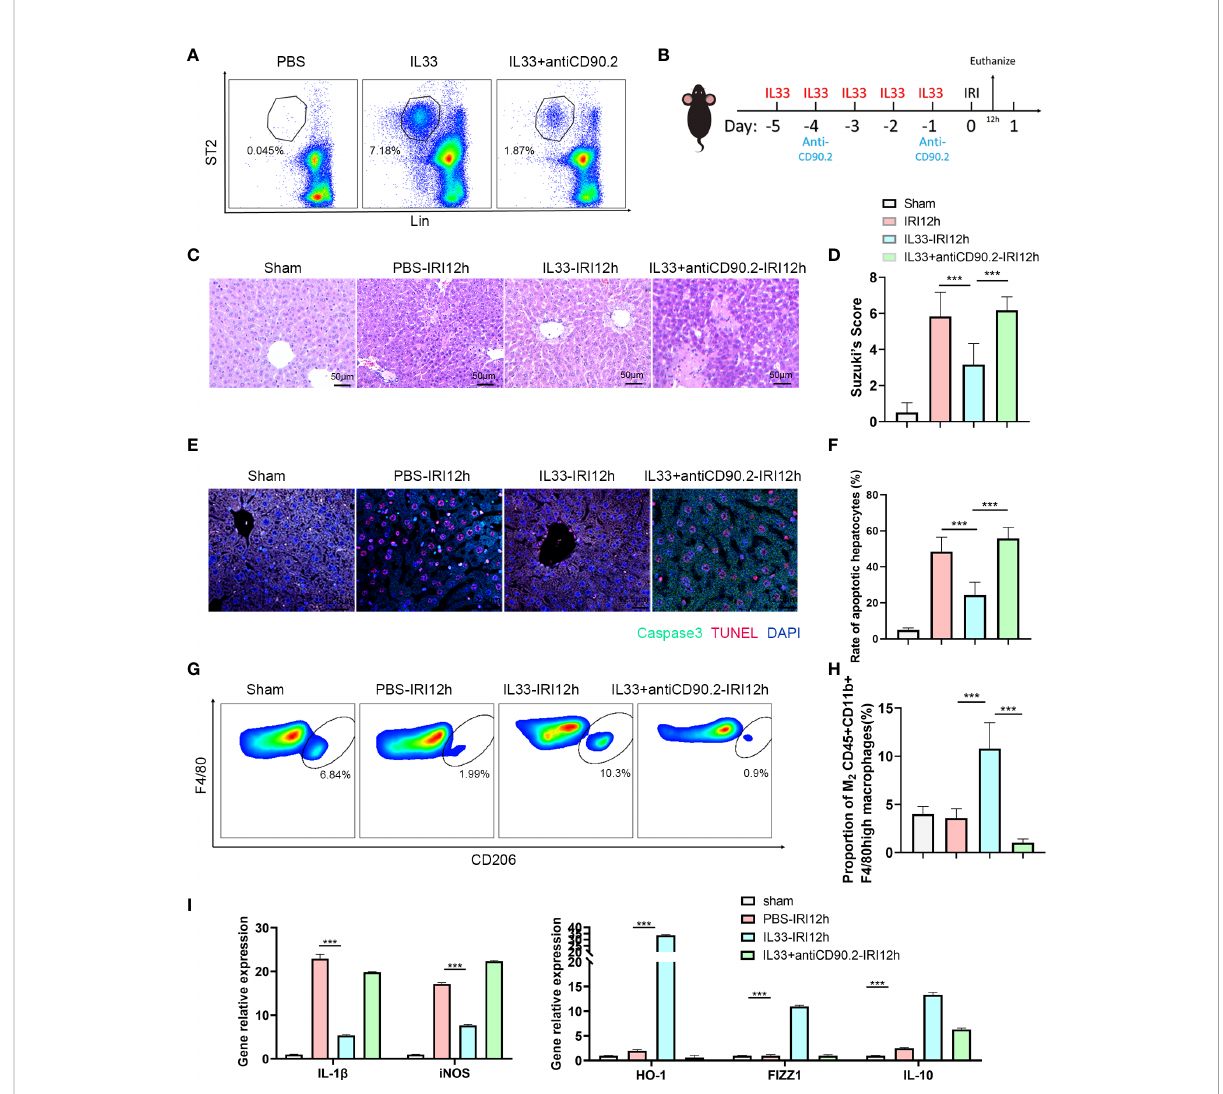
FIGURE 3 ILC2s protect liver from IRI by increasing the proportion of M2 CD45+CD11b+F4/80high macrophages (A) Representative FACS analysis showing that exogenous IL-33 administration signi fi cantly increased the proportion of ILC2s in liver as compared with PBS controls and IL-33 receiving anti-CD90.2 administration, which signi fi cantly depleted ILC2s. (B) Sketch map of medicine administration and IRI surgery. Mice were treated with exogenous IL-33 daily for 5 consecutive days as well as anti-CD90.2 antibody twice before IRI surgery. Mice were euthanized 12 h after reperfusion. (C) HE staining of Sham, PBS, IL-33 and IL33&anti-CD90.2 groups as determined at 12 h after reperfusion (×200). (D) Suzuki ’ s Scores resulting from IR-induced liver injury in Sham, PBS, IL-33 and IL33&anti-CD90.2 groups (n=6 per group). (E) Representative cell apoptosis immuno fl uorescence of the 4 groups as determined at 12 h post-reperfusion. Cell apoptosis was measured using TUNEL (red) and Caspase3 (green). Apoptotic cells display a red nucleus (TUNEL) and green cytoplasm (Caspase-3) while normal cells show blue nuclei (DAPI) (×400). (F) Histograms of quantitative analysis of TUNEL-positive cells (n = 6 per group). (G) Representative FACS analysis showing the proportion change of M2 CD45+CD11b+F4/80high macrophages. (An CD206+ increase in proportion was assumed as a M2 polarization among CD45+CD11b+ F4/80high cells) (H) Quantitative analysis of percent of M2 CD45+CD11b+F4/80high macrophages (n = 5 per group). (I) Relative gene expressions of IL-1 b , iNOS, HO-1, FIZZ1 and IL-10 in macrophages puri fi ed from mice liver in different groups. (*** P <0.05, *** P